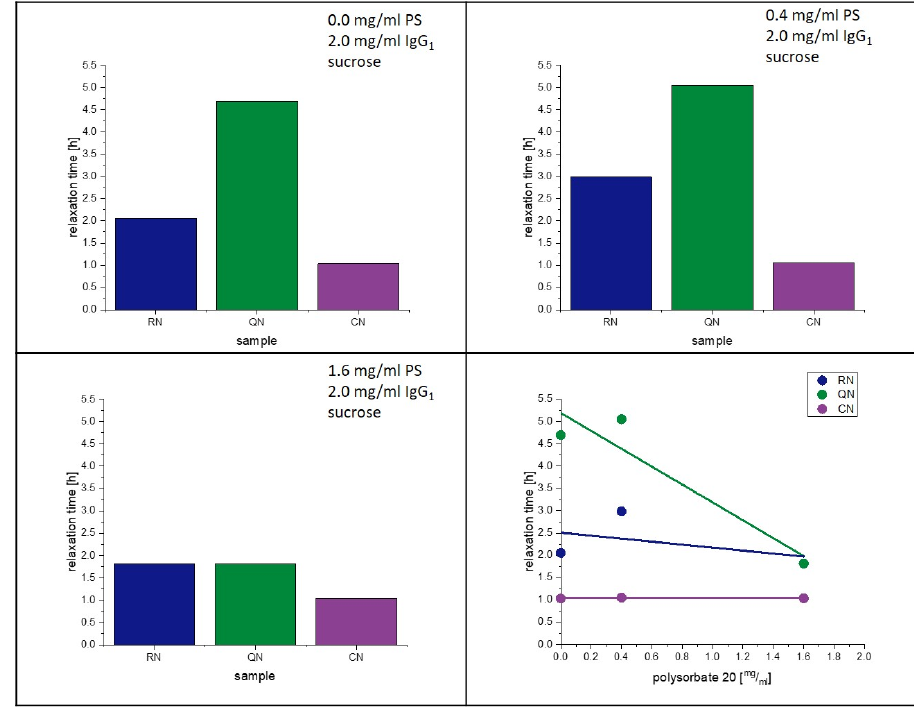
Figure 11. Influence of polysorbate on relaxation at 40 °C.